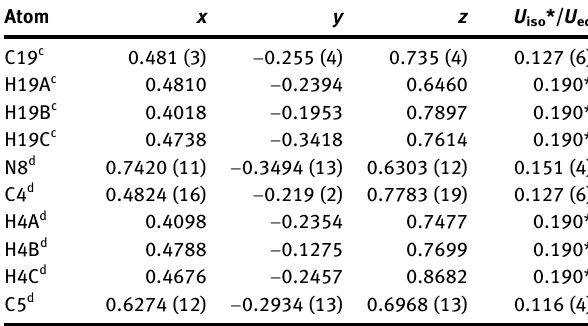
Table  : Fractional atomic coordinates and isotropic or equivalent isotropic displacement parameters (Å 